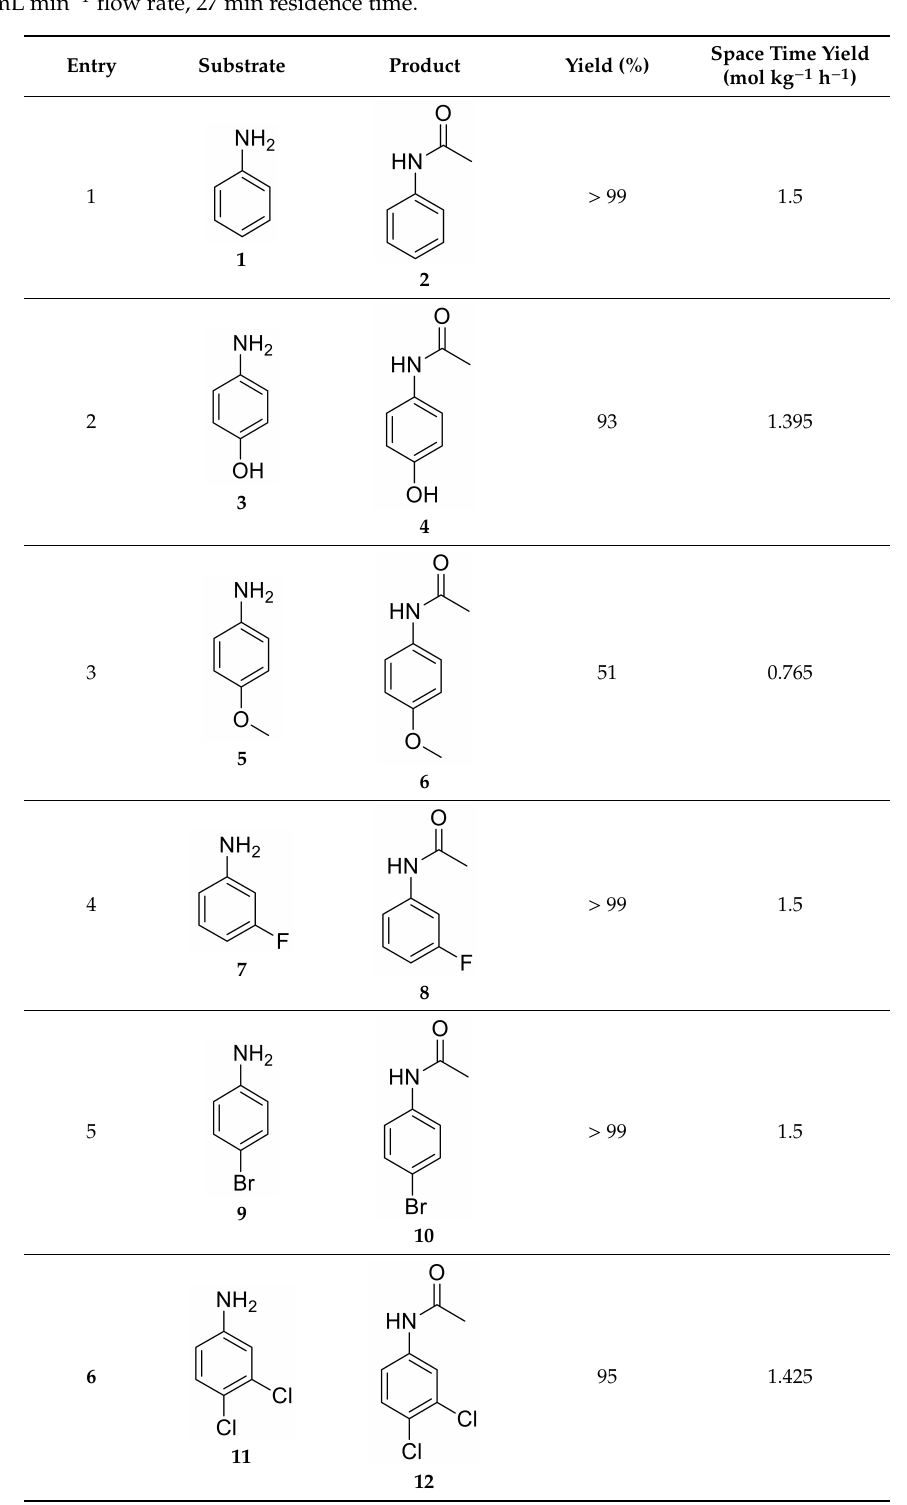
Table 2. Results of the acetylation of various amines obtained at the optimal conditions: 200 ◦ C, 50 bar, 0.1 mL min − 1 flow rate, 27 min residence